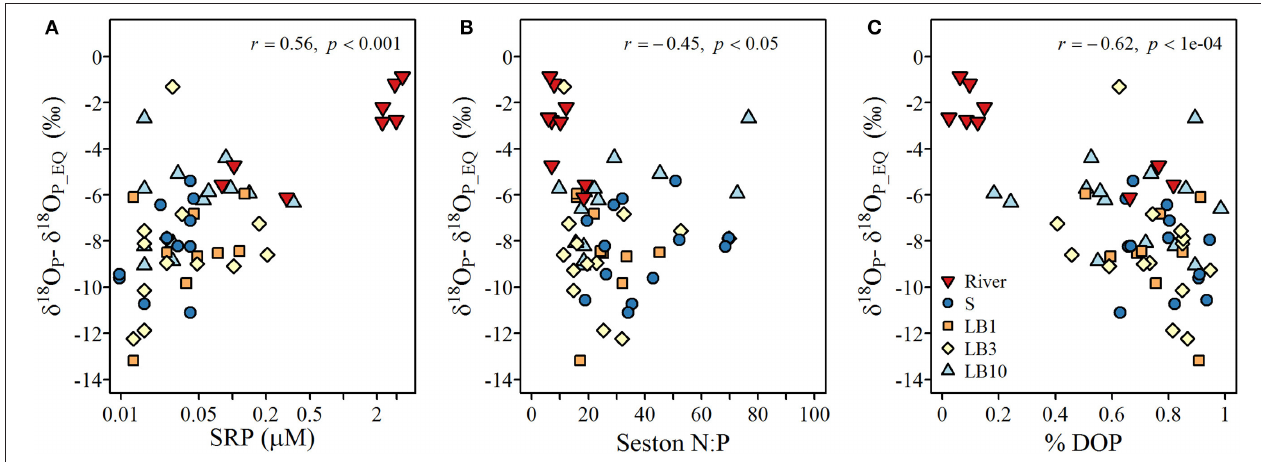
FIGURE 8 | Relationships between (A) the offset of measured δ 18 O p ( ‰ ; symbols) from theoretical δ 18 O P_EQ and soluble reactive P concentrations, (B) offset of measured δ 18 O p ( ‰ ; symbols) from δ 18 O P_EQ and seston N:P ratios, and (C) offset of measured δ 18 O p ( ‰ ; symbols) from δ 18 O P_EQ and % DOP (calculated as (TDP-SRP)/TDP).